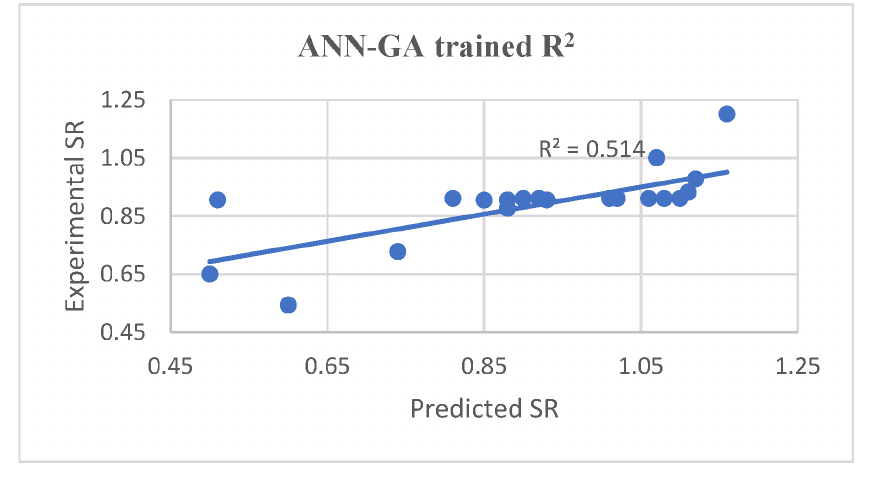
Figure 14. ANN-GA regression line for training.